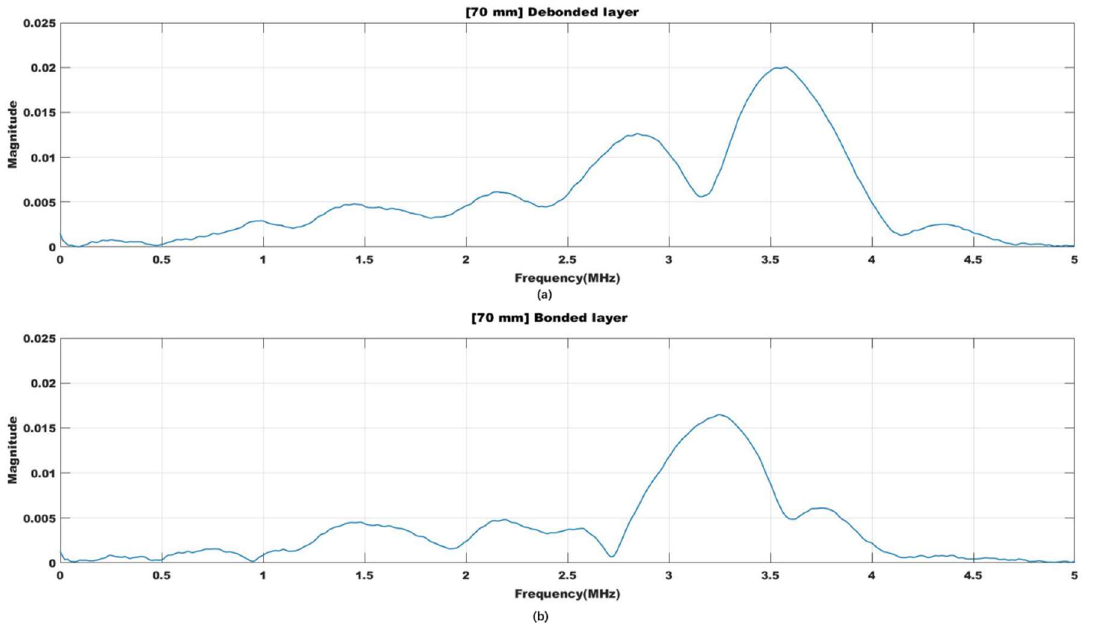
Figure 7. Comparison of the FFT of the bonded zone and debonded zone areas for the same propa- gation distance.